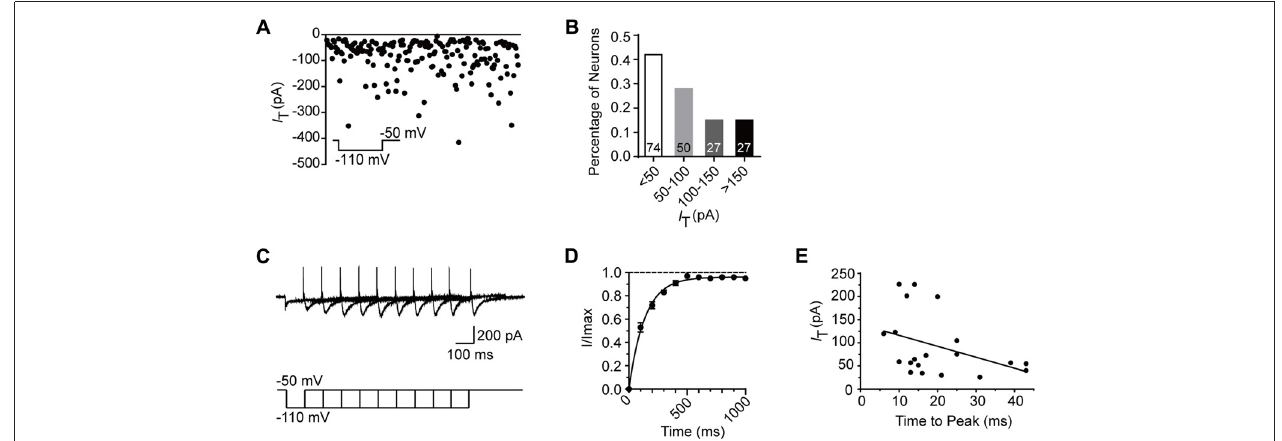
FIGURE 3 | Electrophysiological properties of T-type current in SG neurons. (A) Plots of peak amplitude of T-type current in all the neurons examined from transverse slices ( n = 195). The inset shows the voltage-clamp protocol. Inset: T-type current was activated every 10 s by a 200-ms voltage step to − 50 mV from a holding potential of − 110 mV for 500 ms. (B) Columns of various amplitude of T-type currents in fractions of the total neurons. The numbers in the column indicate the neurons examined. (C) Representative superimposed traces showing currents elicited by voltage steps to − 110 mV of increasing duration. Lower panel shows the voltage-clamp protocol. (D) Recovery from the inactivation. As presented for plots of the relative amplitude of T-type current against the duration of the hyperpolarization which preceded it, fitting with a single exponential equation: I ( t ) = I T × exp( − t / τ ), where I ( t ) is the amplitude of the current at time t, I T represents the amplitude of current, and τ is the time constant. Amplitude values were normalized relative to the maximum amplitude evoked following a 1 s hyperpolarization. (E) Plots of the time to peak vs. the amplitude of T-type current at the duration of 1 s.